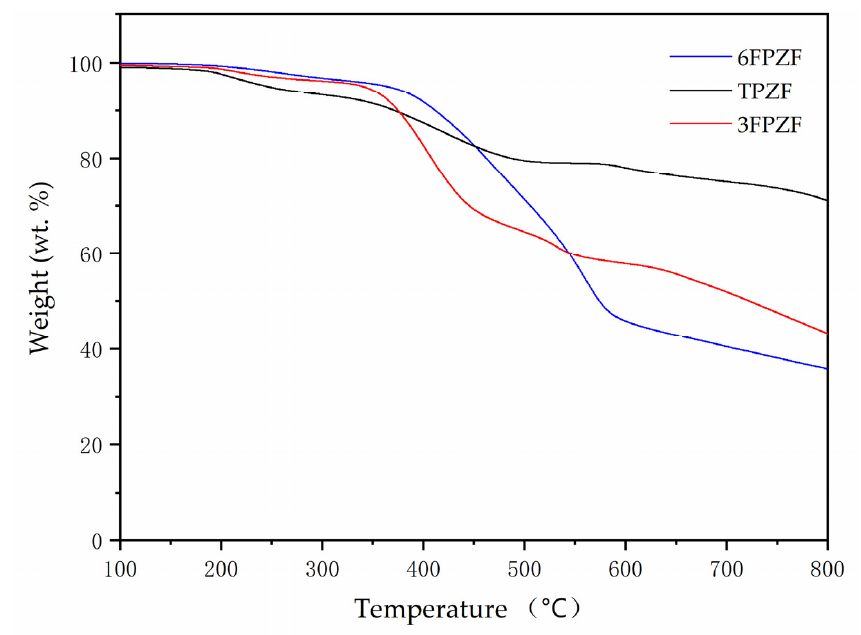
Figure 10. TGA curves of polyphosphazene micro-nanospheres.